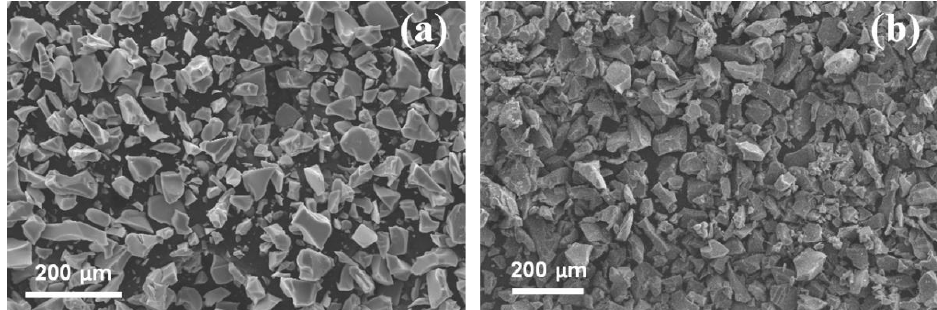
Figure 3. SEM images of catalysts ( a ) Cu/TiO 2 and ( b ) TiO 2 .